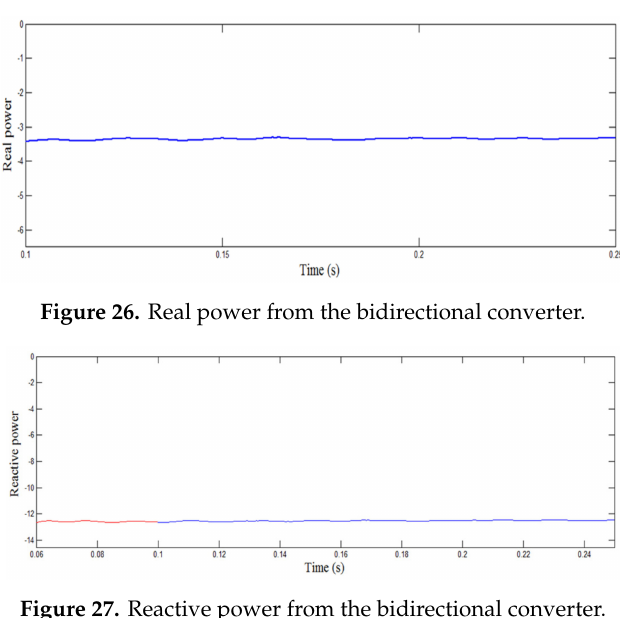
Figure 28. Block diagram of case III.